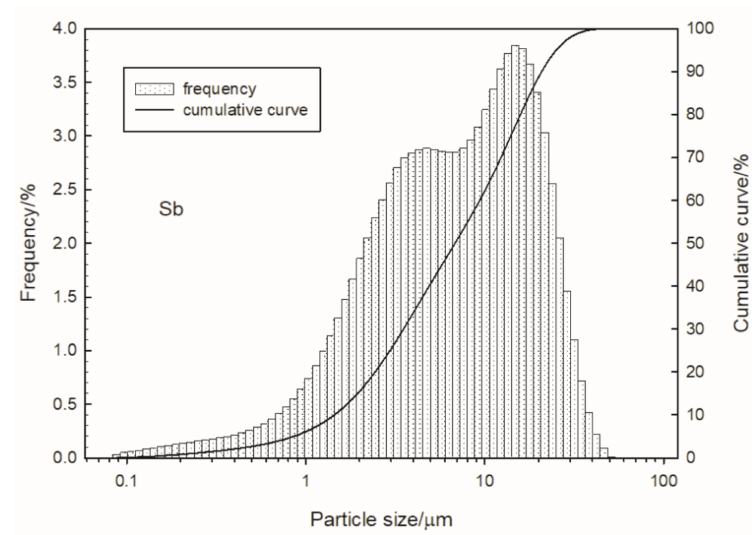
Figure 2. Particle size distribution of antimony.